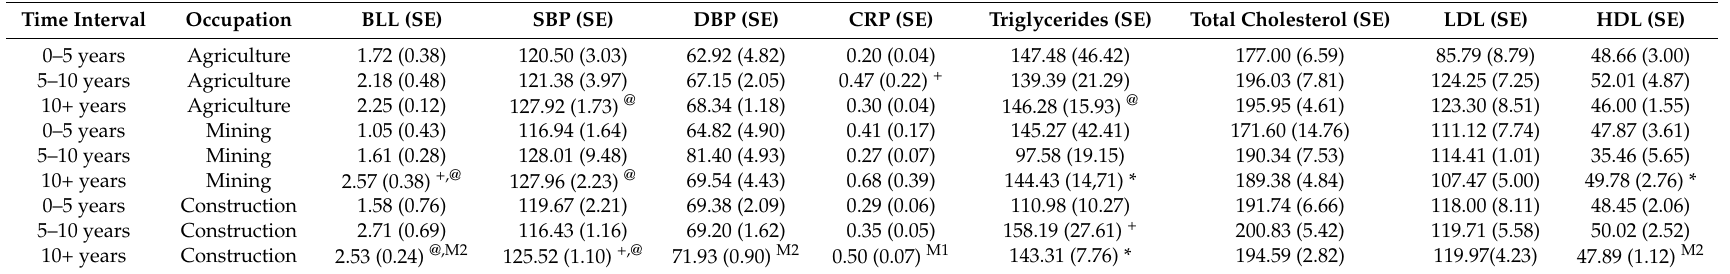
Table 3. Longevity in occupation and health